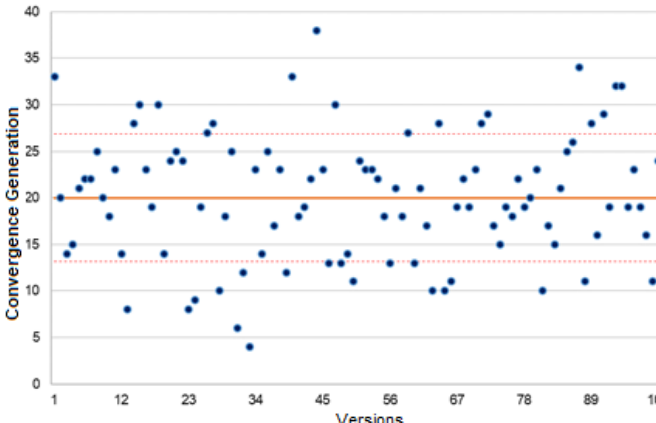
Figure 8. Average generation convergence for DEC.